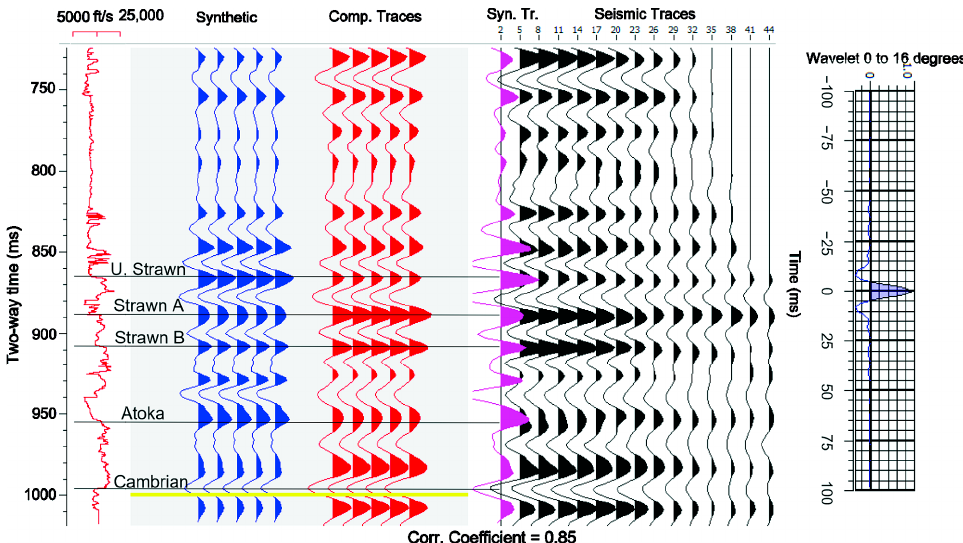
Figure 6. Well-to-seismic tie at well 6. Note: Syn. Tr.—synthetic trace correlated to near trace with correlation coefficient of 0.85 (consistent with other seismic traces). Comp. Traces—composite traces, yellow bar defines base of correlation window, U. Strawn—Upper Strawn.